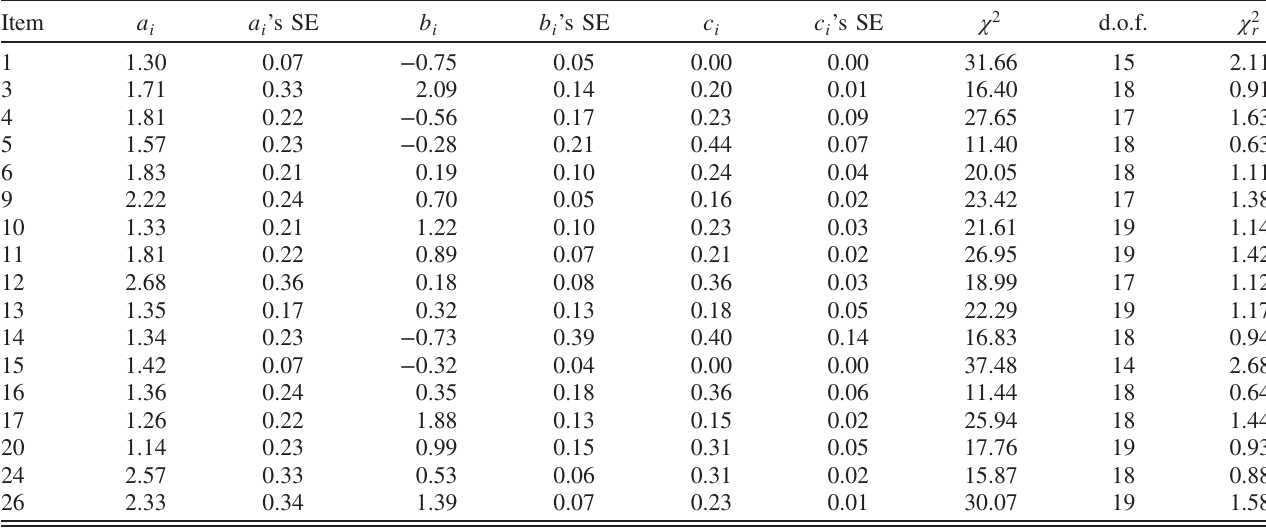
) of the seventeen dichotomous items from the reduced i ) values are also shown. r